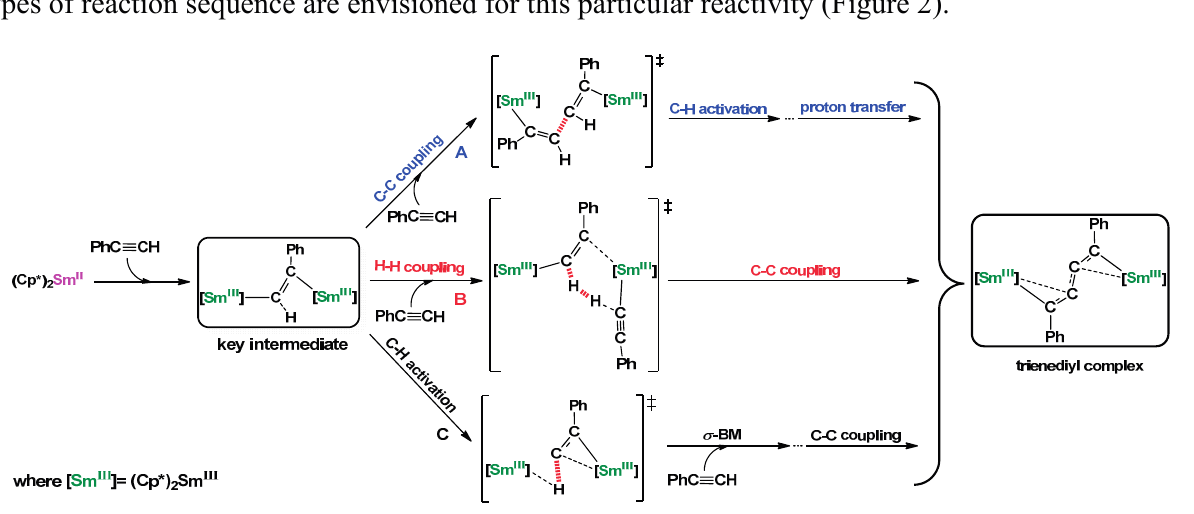
Figure 2. Possible reaction paths A , B , and C leading to the formation of the corresponding trienediyl complex using PhC ≡ CH as the substrate and (Cp * ) 2 Sm as a